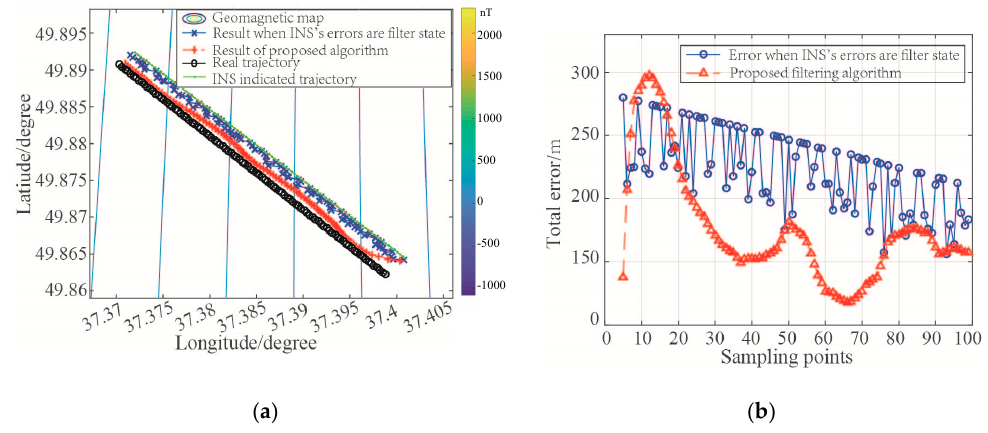
Figure 11. Filtering results of integrated navigation system: ( a ) Filtering trajectories of different algorithms; ( b ) Total location error of different algorithms.